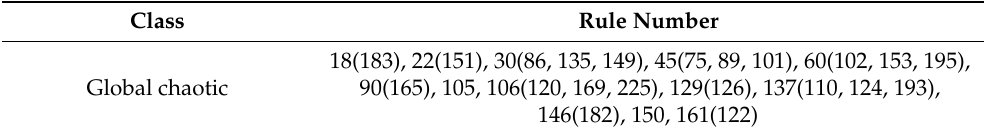
Table 2. The global chaotic rules. The rules in parentheses are similar to the representation rules preceding the